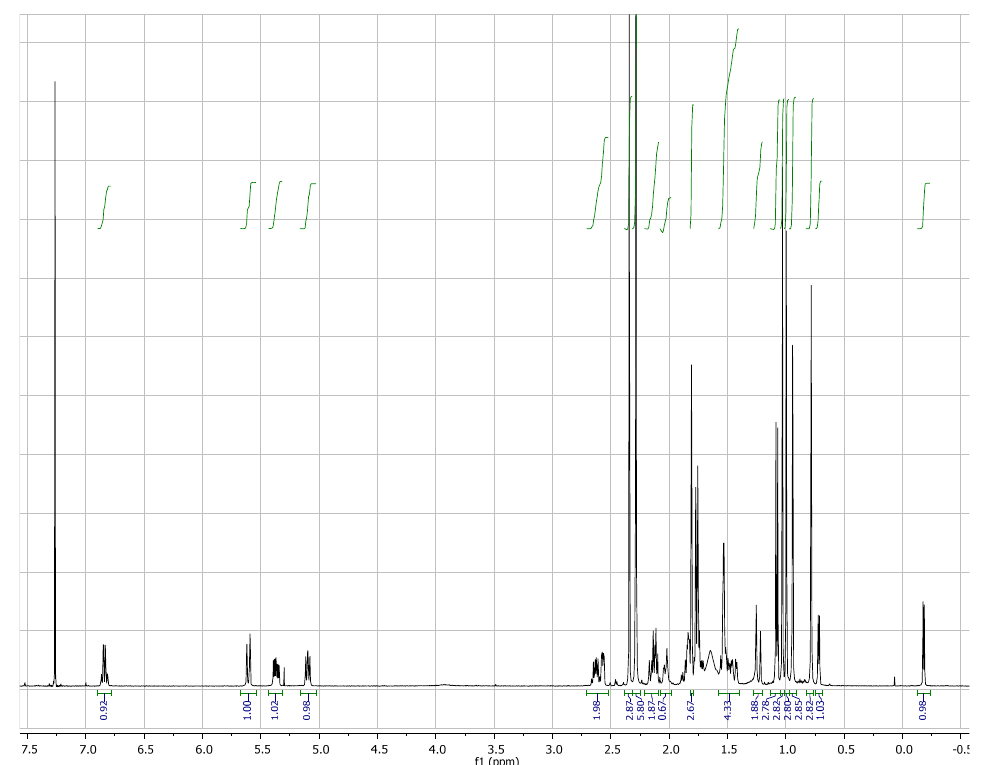
) of compound 1 3